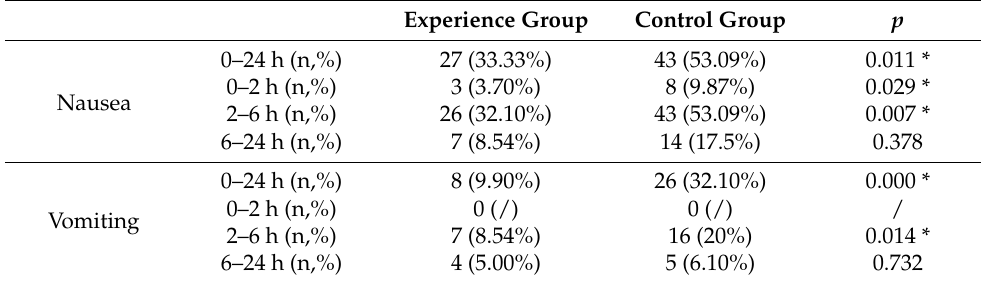
Table 2. Comparison of nausea and vomiting between experimental group and control